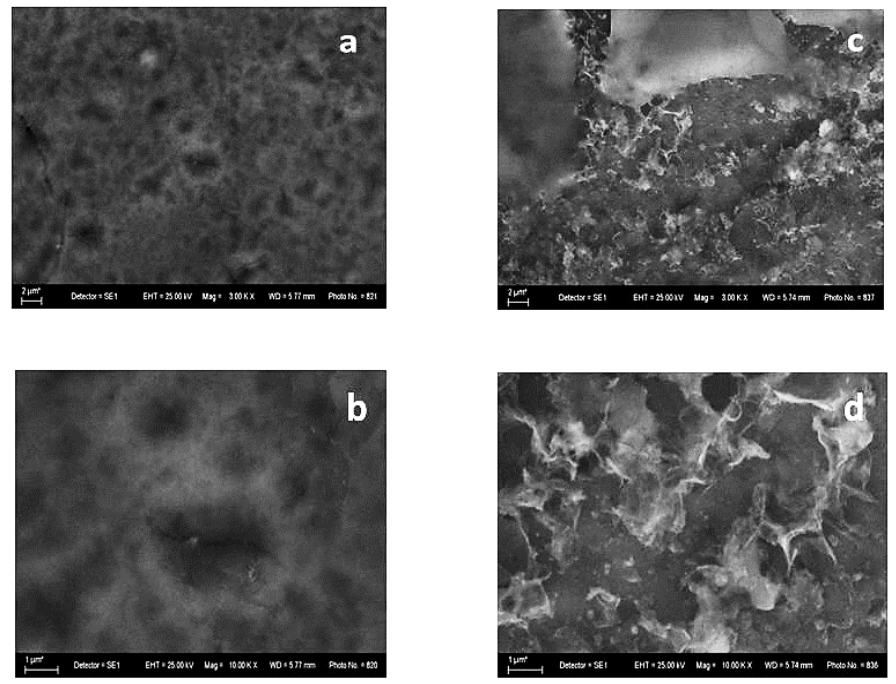
Figure 4. SEM images of System B—fresh sample (left): magnification 3000 ( a ) and 10,000 ( b ) and after corrosive treatment (right): magnification 3000 ( c ) and 10,000 ( d ).